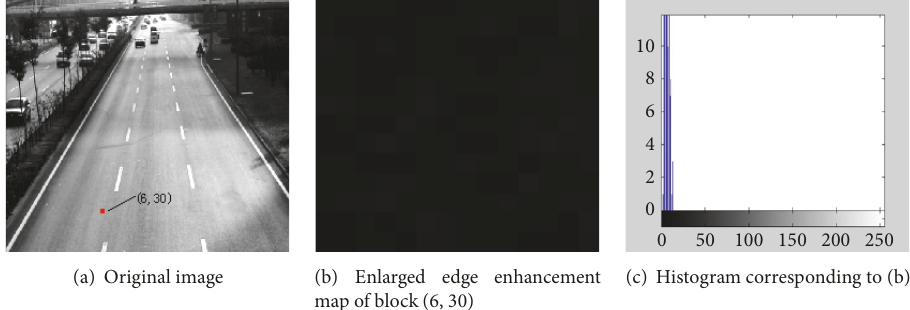
Figure 15: Texture analysis of the false alarm block.